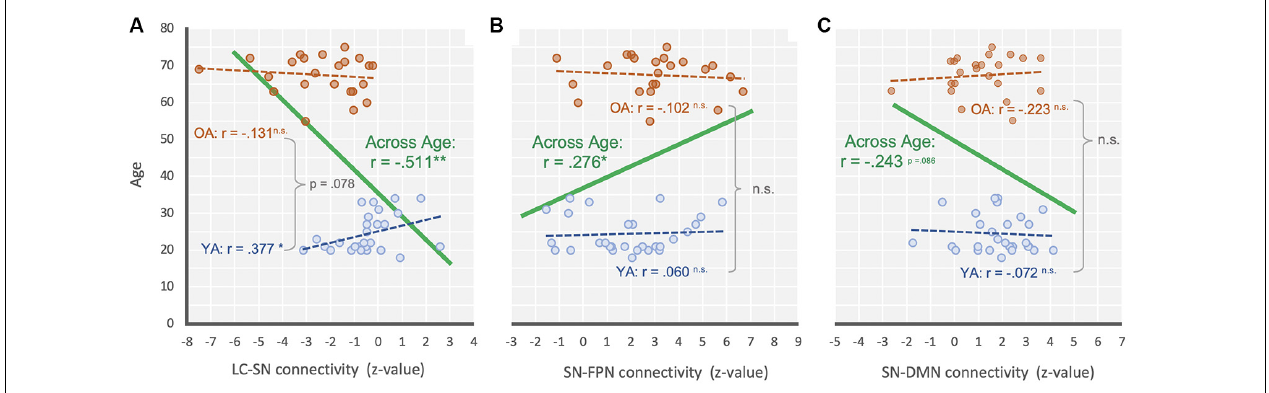
FIGURE 3 | Scatter plot illustrating the relationship between (A) LC-SN, (B) SN-FPN, and (C) SN-DMN connectivity and across age for across range (green), YA only (blue) and OA only (orange). ** P < 0.001; * P < 0.05; n.s.,